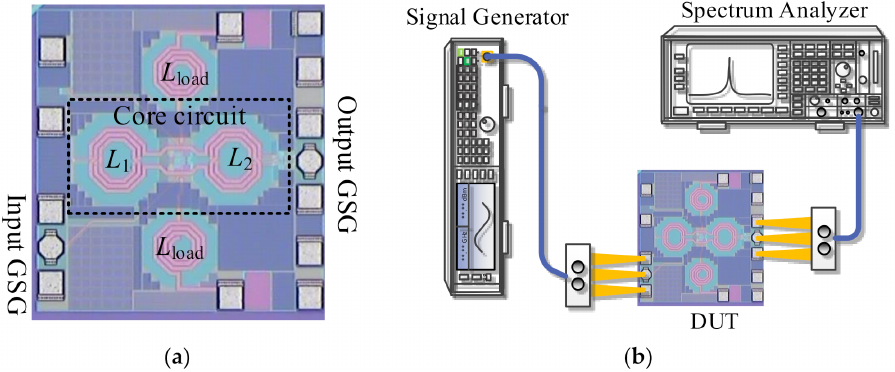
Figure 10. ( a ) Die photo of the proposed ILFD. ( b ) Measurement setup.